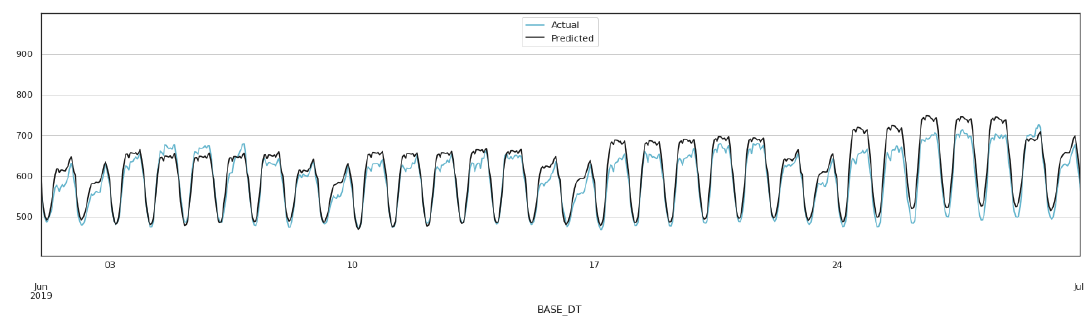
Figure 13. Forecasted load values for the month of June